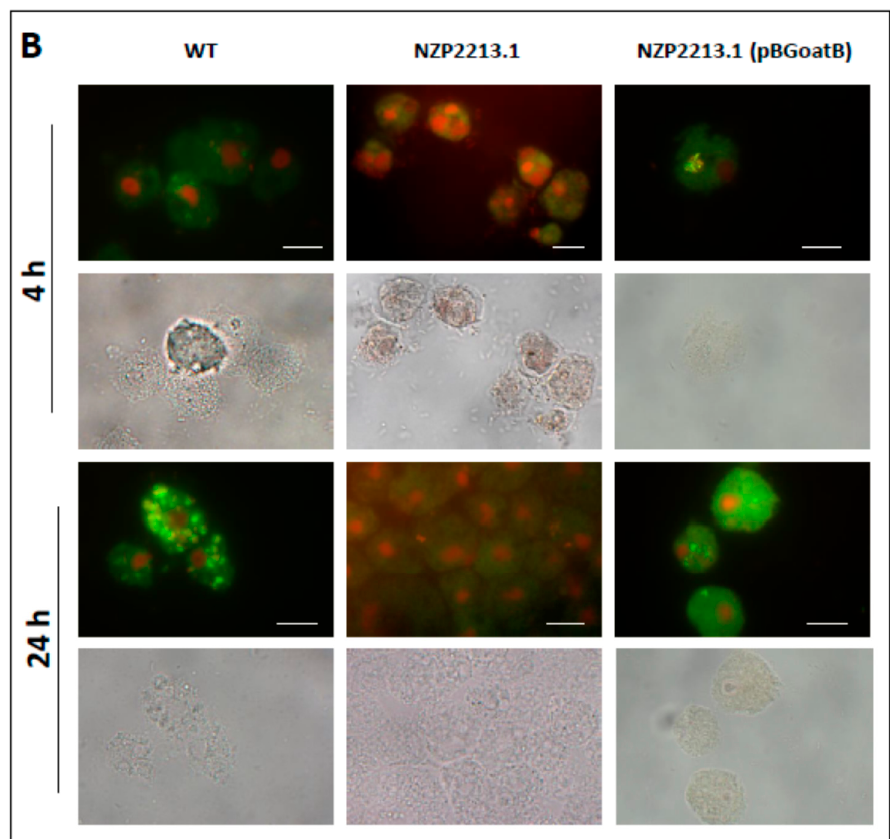
Figure 5. M. loti – A. castellanii co-culture assays. ( A ) Graphs represent average counts of M. loti cells internalized by amoebae per one well of a tissue culture plate. CFU counts of viable bacteria were estimated for 4- and 24-h co-culture assays and for phagolysosome inhibition assays, in which NH 4 Cl was used to alkalinize phagolysosome compartments. In the LIVE/DEAD assays, the total number of internalized bacteria (viable and non-viable) was calculated from registered images representing at least 200 randomly selected amoebae cells. ( B ) Differential LIVE/DEAD fluorescence staining of M. loti within A. castellanii vesicles after 4-h and 24-h co-incubation. Green fluorescence indicates metabolically active bacterial cells with an intact membrane; the red-stained bacteria are considered metabolically inactive. Images were collected on a Zeiss LSM780 laser scanning confocal microscope with excitation light using dual color channels (upper panels). The same samples were also registered using transmitted light (lower panels). Bars represent 10 µm. Details of the experiments are described in Section 4.